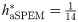
Analysis of inter-individual differences.(A) We analyzed the behavior of the n = 12 participants individually, by searching for each participant the best value of the model’s single free parameter, the hazard rate h. Estimates were performed independently on both experiments, such that we extracted different estimates of haSPEM and hbet respectively for the anticipatory pursuit velocity and the rating value. The dots correspond to independent estimates of the hazard rate for each individual participant are shown as dots, while the radius is proportional to the squared Person’s correlation coefficient. This plot shows that best fit hazard rates have a median value of haSPEM*=114 and hbet*=136. The values are in general higher than the ground truth (blue line), and in general higher for eye movements (below the diagonal). Note that the dispersion of hazard-rate best-fit estimates is narrower for the eye movement session than for the bet experiment. Such an analysis may suggest that participants ultimately have different mechanisms at the implicit (anticipatory pursuit) and explicit (ratings) levels for guiding their tendency of exploitation versus exploration. (B) To illustrate the models corresponding to these best-fitted values of the hazard rates, we show the predicted probability to the same sequence of TDs, with the lowest (1162), optimal (140) and highest (16) hazard rates (respectively from top to bottom).